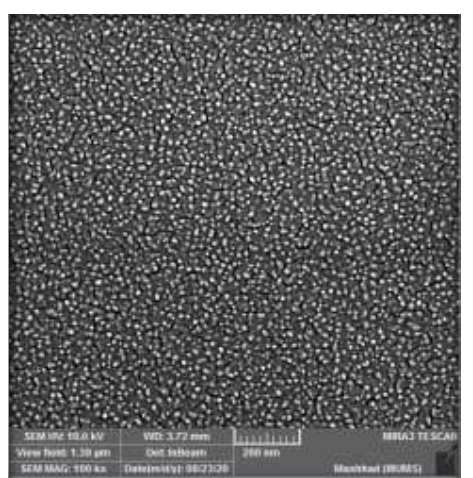
pure at (200 nm and 500 nm) scale. 2